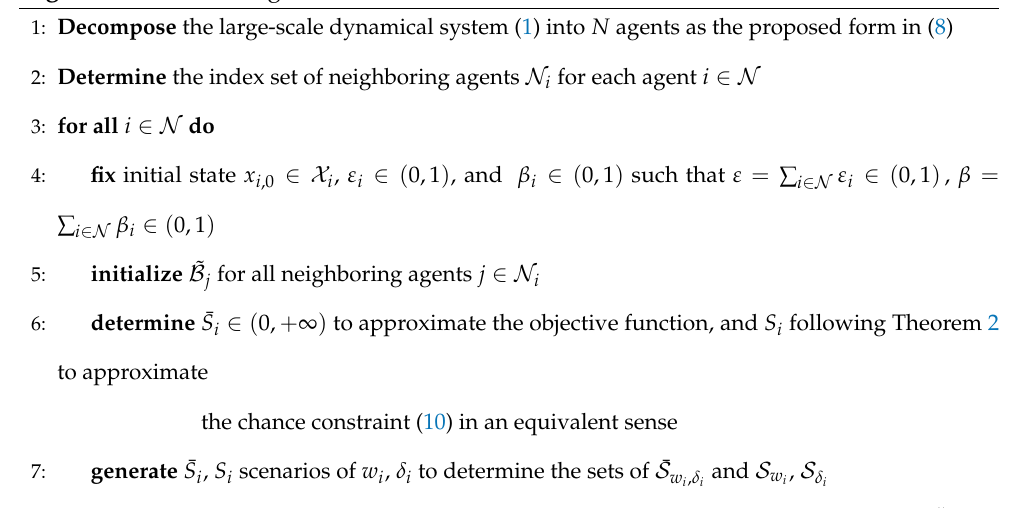
Algorithm 3 DSO using Soft Communication